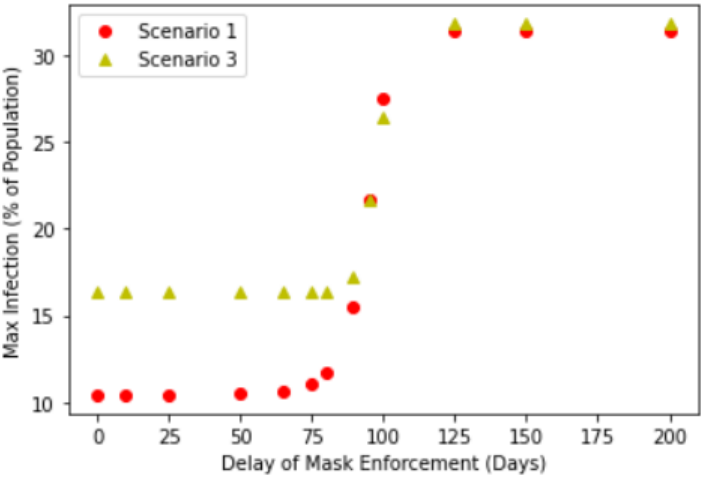
Figure 4. Maximum infection against delay in mask enforcement for Scenario 2: SEIR with full compliance and Scenario 3: SEIRS with time-limited